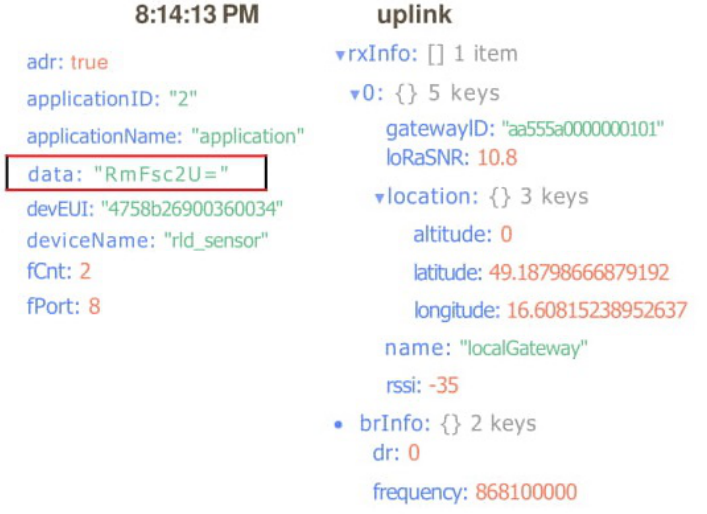
Figure 16. Fake message injected in LoRaWAN NS